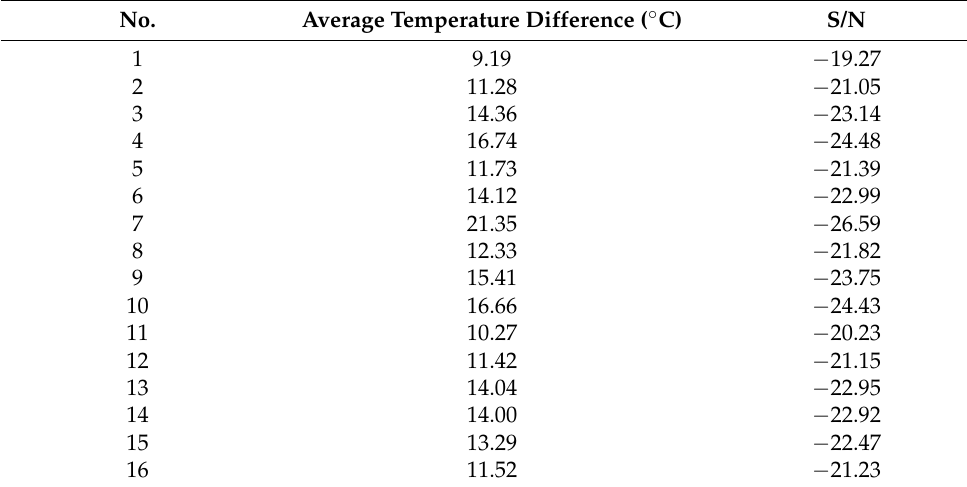
Table 10. S/N Ratios of Average Temperature Difference.